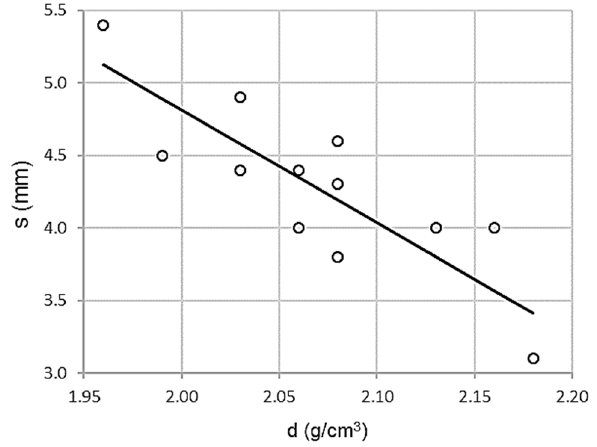
Figure 3. Scatterplot for in-situ density and topographic settlement test.